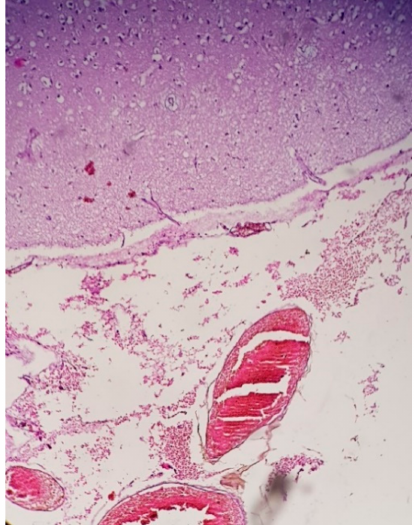
Figure 1. 100 × hematoxylin–eosin (HE) stain of fetal brain tissue fragment demonstrating lep- tomeningeal vascular microthrombosis and red blood cell extravasation, meningeal edema, and nervous tissue without major